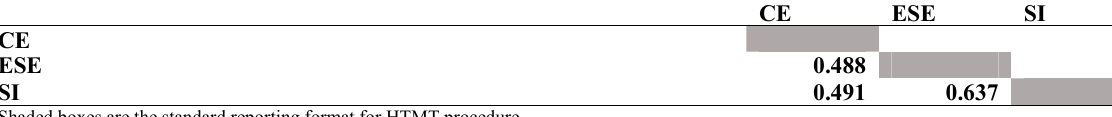
Heterotrait-monotrait (HTMT)